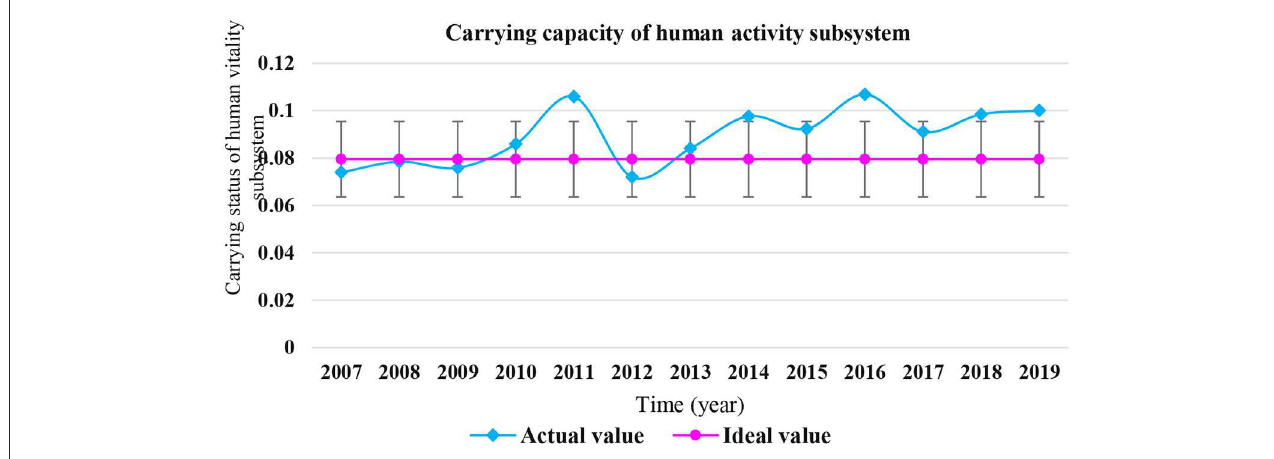
FIGURE8 Carrying status of coastal human vitality subsystem in Shandong Province from 2007 to 2019.